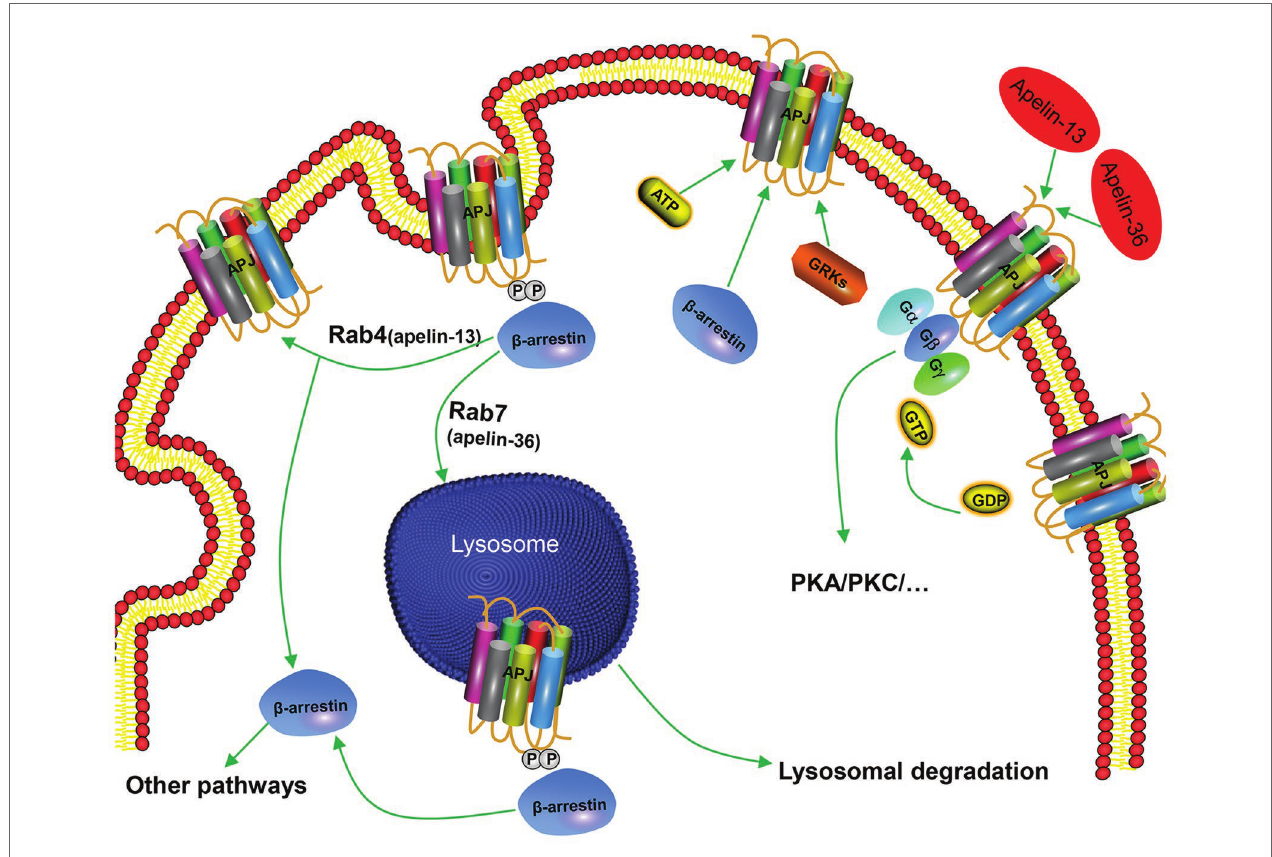
FIGURE 3 | Mechanism of β -arrestin-dependent APJ desensitization and endocytosis. Apelin-36 binds to APJ and forms APJ/apelin-36 complex, which is localized to intracellular lysosome through Rab7 signaling pathway, leading to persistent desensitization of APJ, while apelin-13 forms APJ/apelin-13 complex with APJ and then rapidly circulates APJ to the cell surface through Rab4 signaling pathway, leading to transient desensitization of